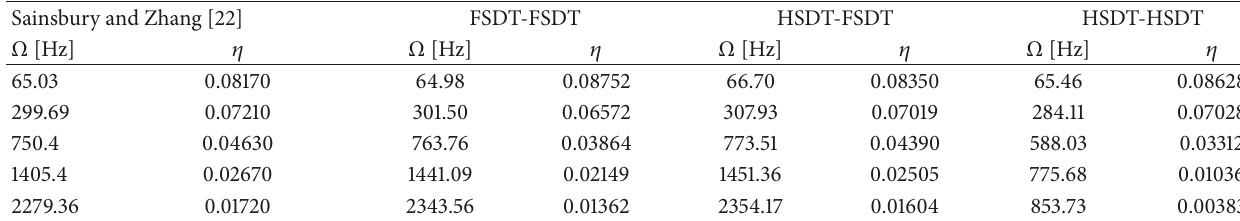
Table 4: Frequencies and loss factors 𝜂 .